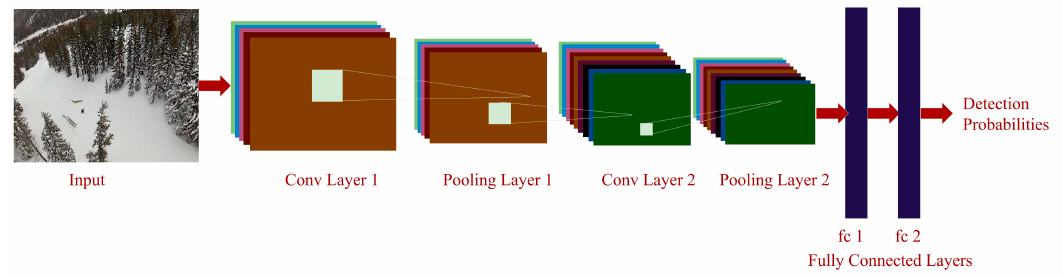
Figure 2. Example of CNN architecture for object recognition.